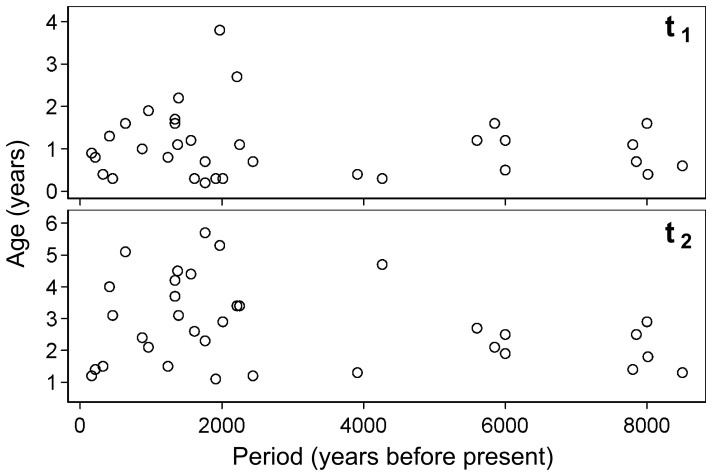
Maximum density weaning ages plotted by the midpoint time period for the populations.